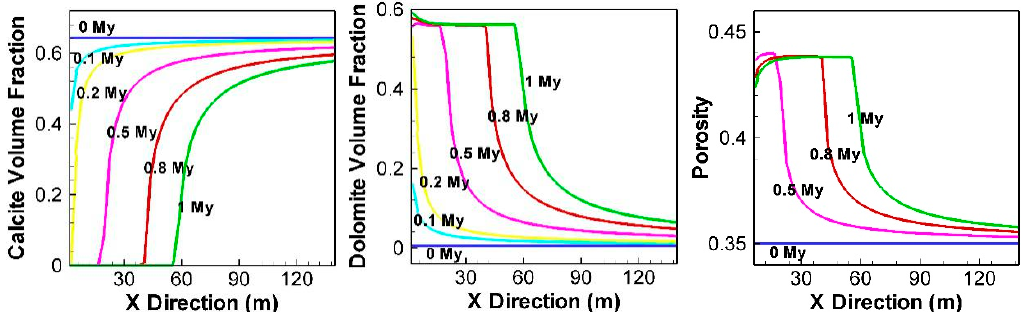
Figure 4. Calcite and dolomite content and porosity evolution (Base Case).